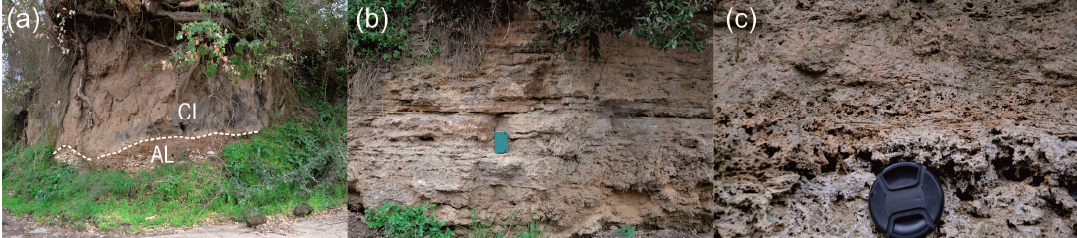
Figure 12. ( a ) One of the escarpment bordering the CI-T towards the Calore River valley floor, showing the contact be- tween the pyroclastic deposits (CI) and the underlying alluvial unit 1a (AL); ( b ) the Amorosi travertines; ( c ) the Telese travertines.